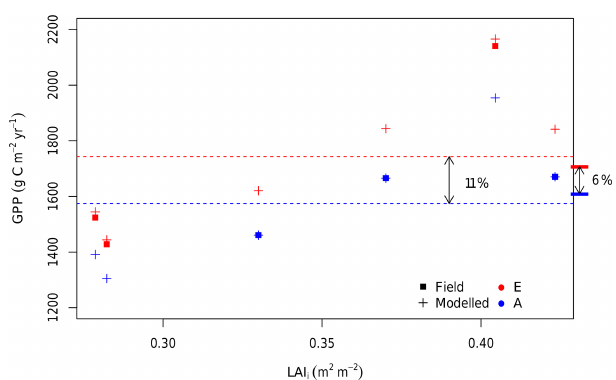
Figure 8. The 4-year average GPP of all six rings under ambient and e C a conditions plotted against the initial leaf area index (LAI i ). The LAI i is the LAI measurement taken on the 26 October 2012 and is a proxy for the inherent variation among the rings. For all six rings, the estimated GPP is shown for ambient C a (blue) and e C a (red). Crosses indicate the GPP from simulations in which the C a is varied, and squares indicate the GPP under field conditions. The flat bars on the right-hand side of the plot indicate the average ambient C a GPP for ambient rings only (the average of blue squares) and the average e C a GPP for elevated rings only (the average of red squares). Dashed lines indicate the average ambient C a (the average of blue crosses) and the e C a GPP across all six rings (the average of red crosses). Thus, the flat bars mark the modelled response without inter-ring variability, whereas the dashed lines mark the modelled realized response, including inter-ring